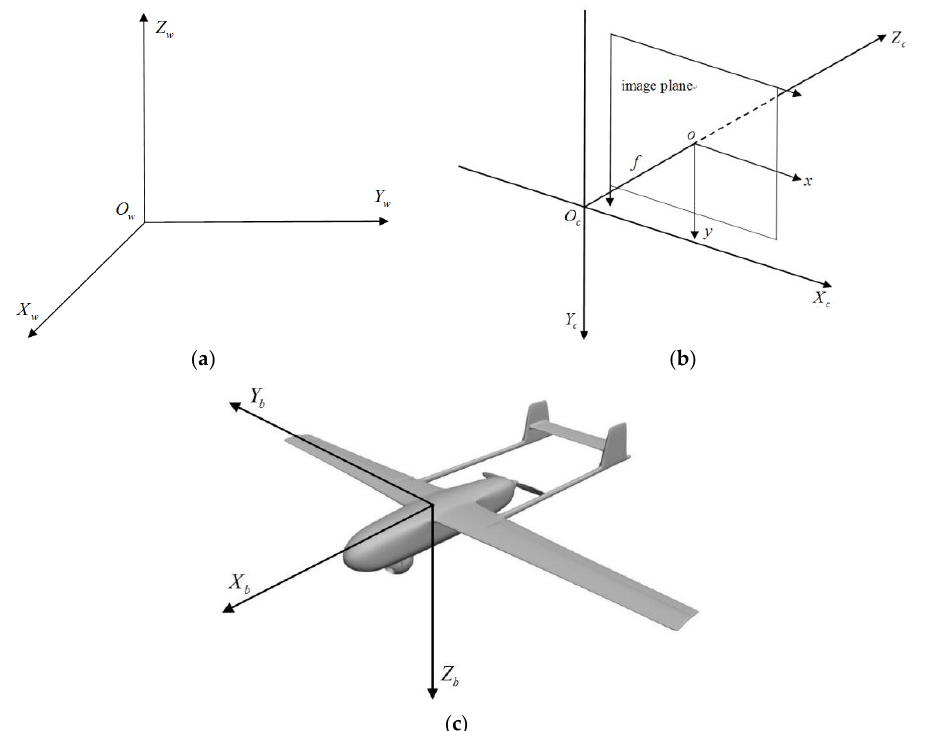
Figure 1. Coordinate systems: ( a ) World frame; ( b ) Camera frame; ( c ) Body frame.